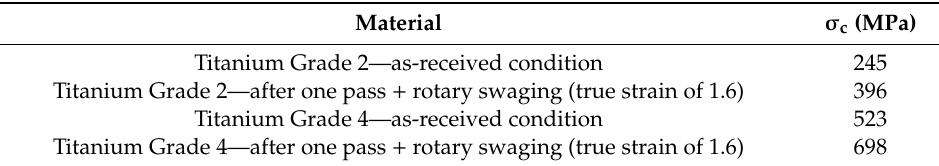
Table 3. Results of fatigue testing for pure titanium in as-received and mechanically-worked conditions.